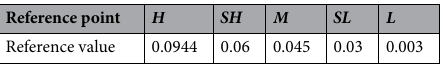
Table 1. Reference points and values for FR .